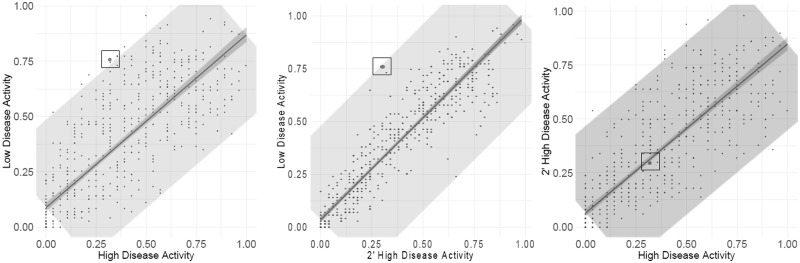
Identification of an example outlier protein (in the square) as a predictor of disease activity from the assessment of missing values. The outlier protein is identified as an outlier due to increased missingness count in low disease activity participants when compared to both types of high disease activity groups. The protein’s missingness does not separate those at particularly high disease activity participants from secondary high disease activity participants. The shaded area is a line parallel to the linear regression line, expanded in size